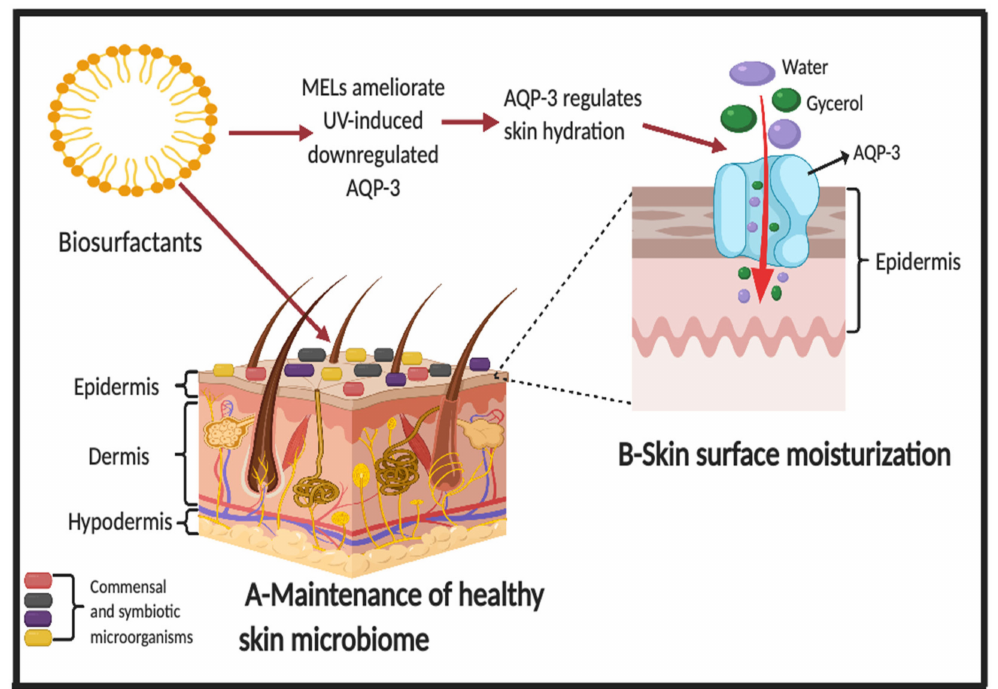
Figure 3. Potential benefits of microbial glycolipid and lipopeptide biosurfactants on human skin and its microbiome. ( A ) Maintenance of healthy skin microbiome; ( B ) Skin surface moisturization. AQP-3 = Aquaporin 3, MELs = Mannosylerythritol lipids. Figure adapted from [3,31,128] with permission from Taylor & Francis for [31], 2017 and created with